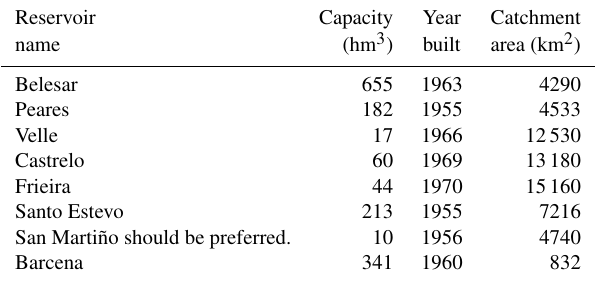
Table 1. List of dams analyzed in the study (data provided by Con- federación Hidrográfica del